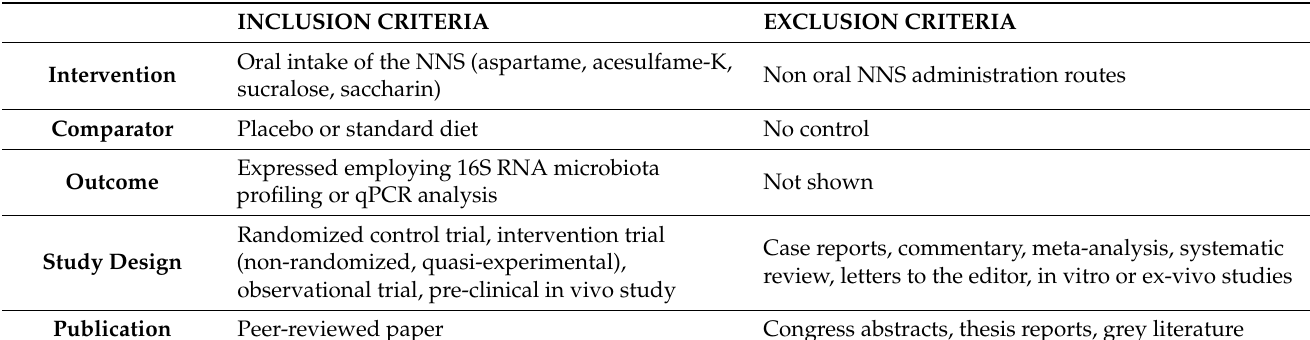
Table 1. Summary of inclusion and exclusion criteria employed for the studies’